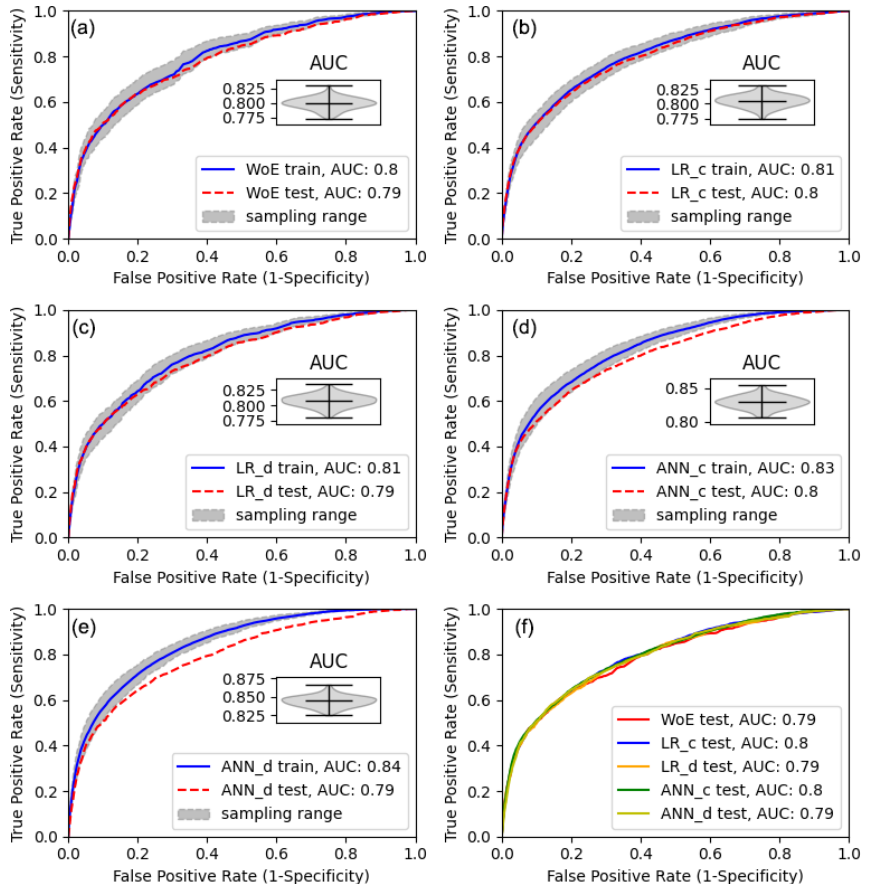
Figure 10. ROC curves for the different models. The greyish band marks the model uncertainty based on the MSE. The insert in (a) – (e) shows the corresponding distribution of AUC values for the utilized